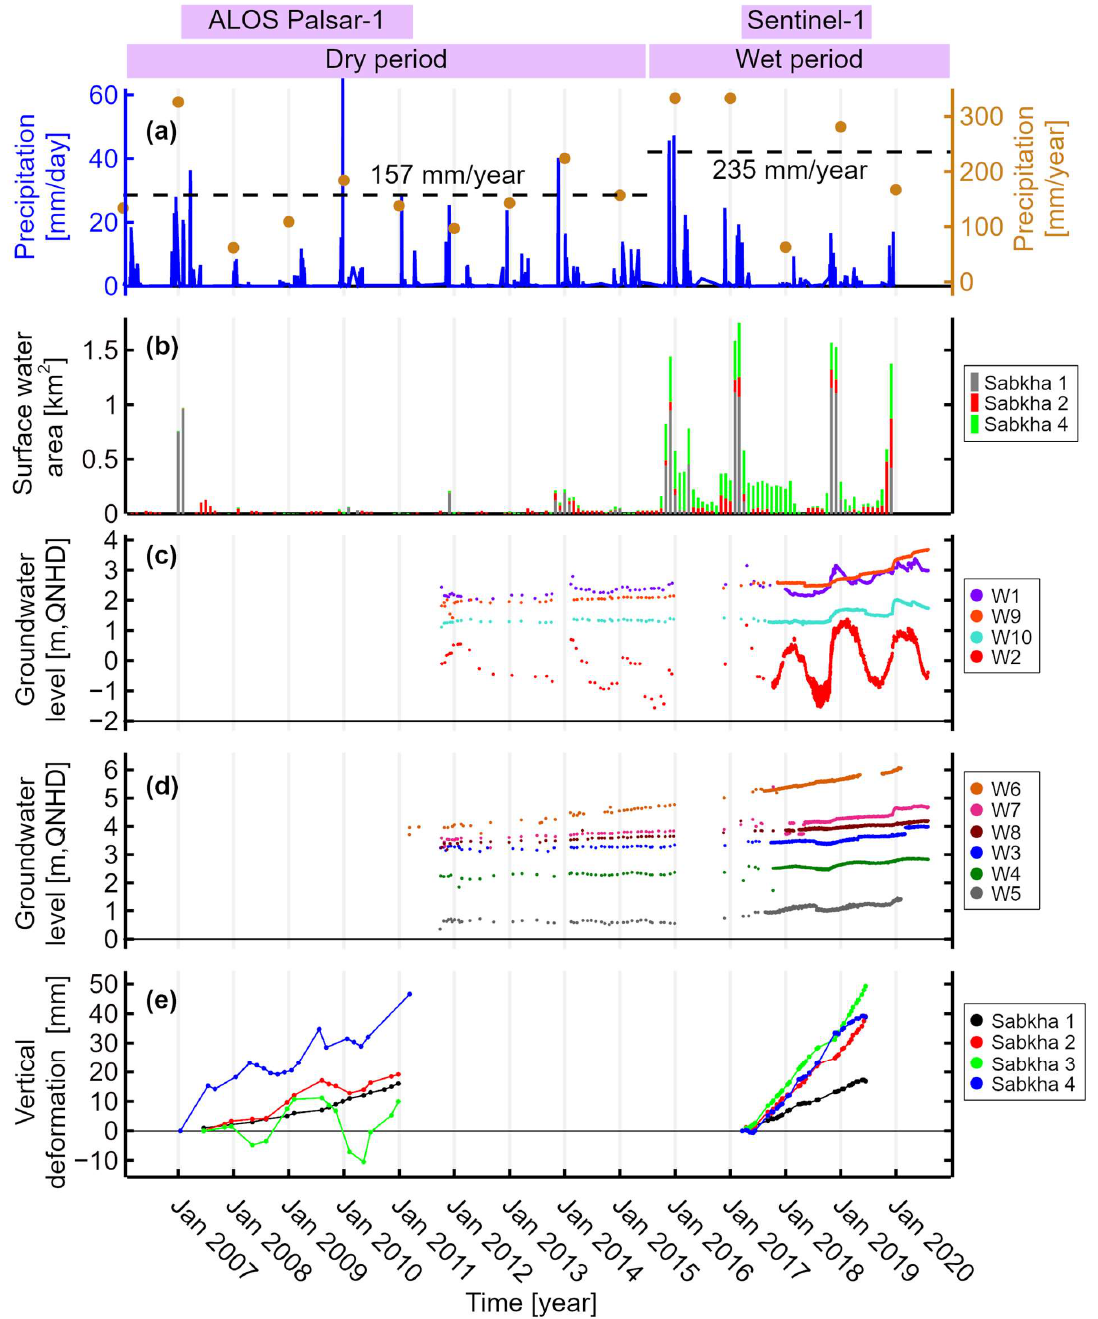
Figure 5. Comparison between precipitation over Qatar during the dry (2016–2015) and the wet (2016–2020) periods with the temporal variations in surface water area within sabkhas 1, 2, and 4, groundwater levels in proximal wells and cumulative vertical deformation over sabkhas 1, 2, 3 and 4. The ALOS Palsar-1 and Sentinel-1 data were acquired during the dry and wet periods, respectively. ( a ) Time series of daily (blue lines) and annual (brown dots) precipitation (extracted from [43]). ( b ) Stacked time series of surface water area within the prominent sabkhas (1, 2, and 4) extracted from Landsat-based global surface water dataset [48]. No surface water was detected within Sabkha 3 throughout the observation period (2006–2019). ( c , d ) Time series of groundwater level in m in reference to the Qatar National Height Datum (QNHD) for wells W1–W10. The groundwater level data was provided by MME Public Works Authority Project CP761/1: Shallow Groundwater Monitoring Phase II. ( e ) Time series of cumulative vertical deformation over sabkhas 1, 2, 3, and 4 extracted from ALOS Palsar-1 and Sentinel-1 datasets. Time series of deformation were calculated by averaging all the pixels within the sabkha polygons shown in Figure 4. Abbreviations are defined in caption of Figure